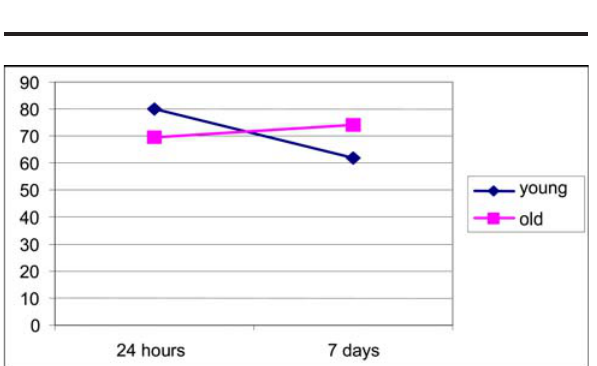
FIGURE 4 - Average of PCNA-positive nuclei